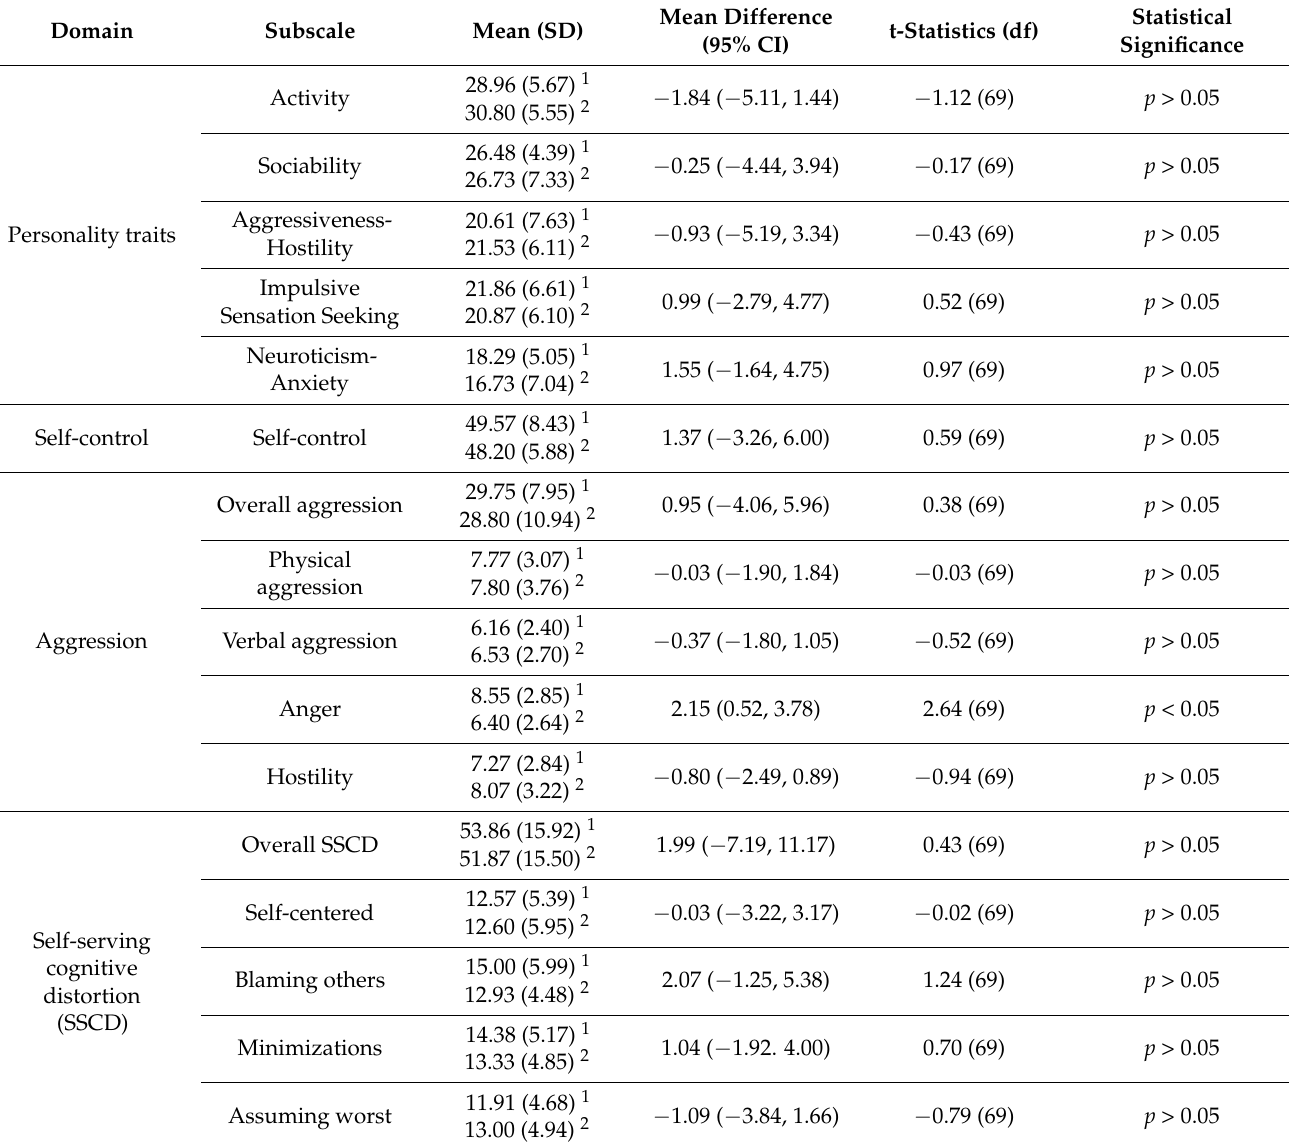
Table 3. Comparison of psychological mean scores between the between participants who committed murder concealment acts with those who did not ( n = 71).